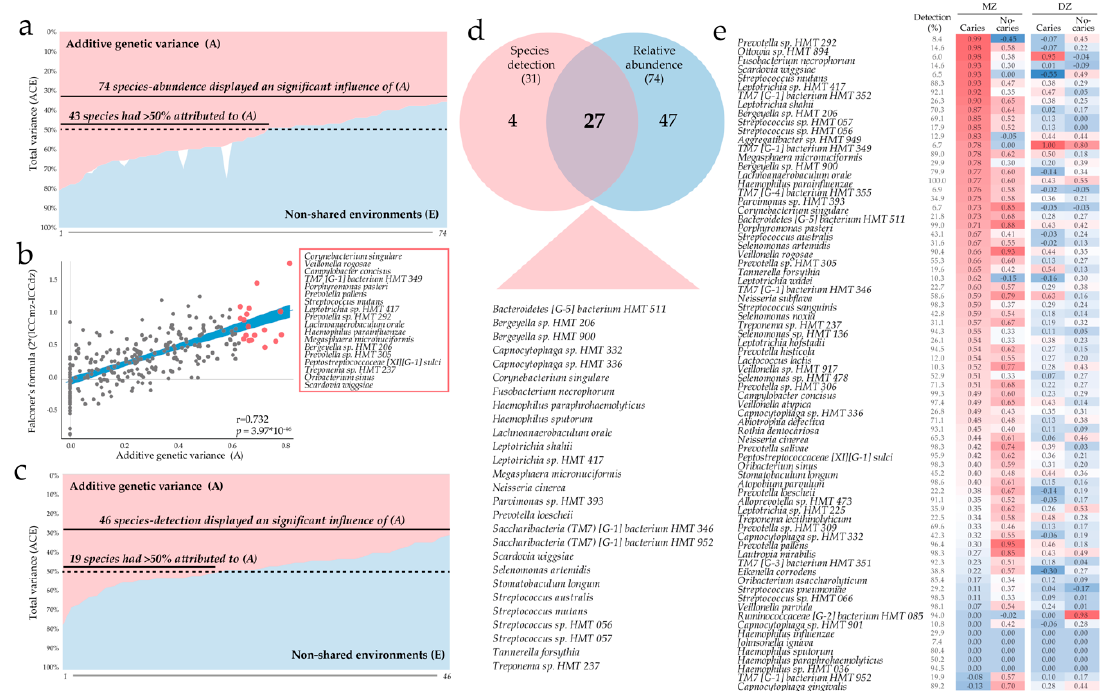
Figure 4. Oral microbiota heritability. ( a ) additive genetic (A) versus unique environment (E) scores for bacterial species with sex, birth-year, and Illumina run adjusted statistically significant A score for species abundance; ( b ) comparison of A scores for abundance and scores by the Falconer’s formula (2 × (ICCmz-ICCdz); ( c ) A and E score for species detection of species. Variance explained by component C in ( a ) and ( c ) is shown in white. ( d ) Venn diagram showing bacterial species with a statistically significant A score for both detection and abundance ( n = 27); ( e ) heatmap showing ICC scores for bacterial species with a statistically significant A score by MZ and DZ and caries status (caries-free versus caries-affected) .